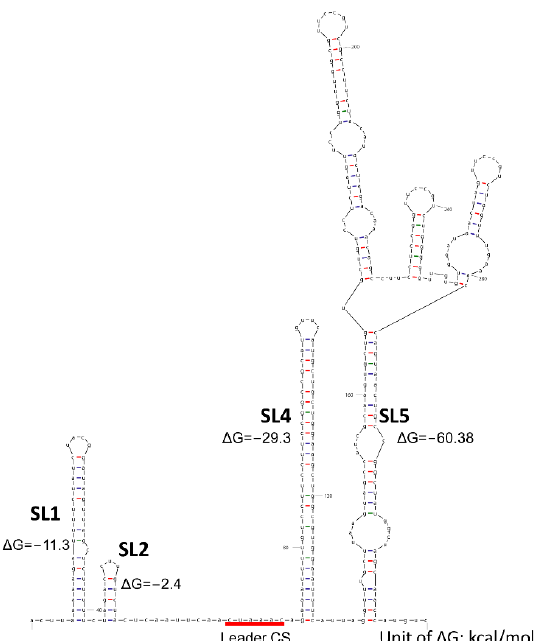
Figure 3. Secondary structures for the 5 ′ UTR of the prototype PEDV CV777 strain. Four conserved stem-loops (SLs) are predicted using Mfold [http://www.unafold.org/mfold/applications/rna-folding-form.php (accessed on 26 May 2022)], and Gibbs free energy for each SL was calculated and presented in kcal/mol.